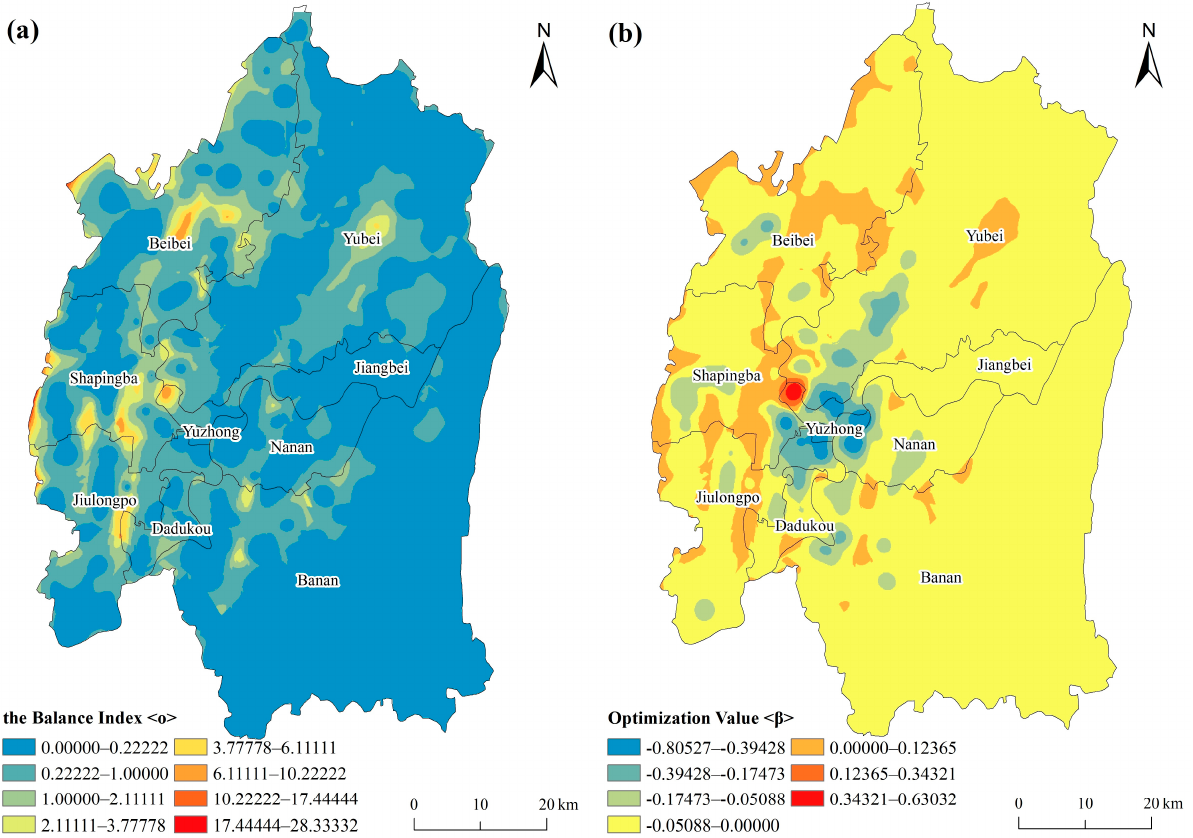
Figure 5. ( a ) Matching supply and demand of EV charging infrastructure in the central urban area of Chongqing (corrected); ( b ) spatial layout optimization map of EV charging infrastructure in the central urban area of